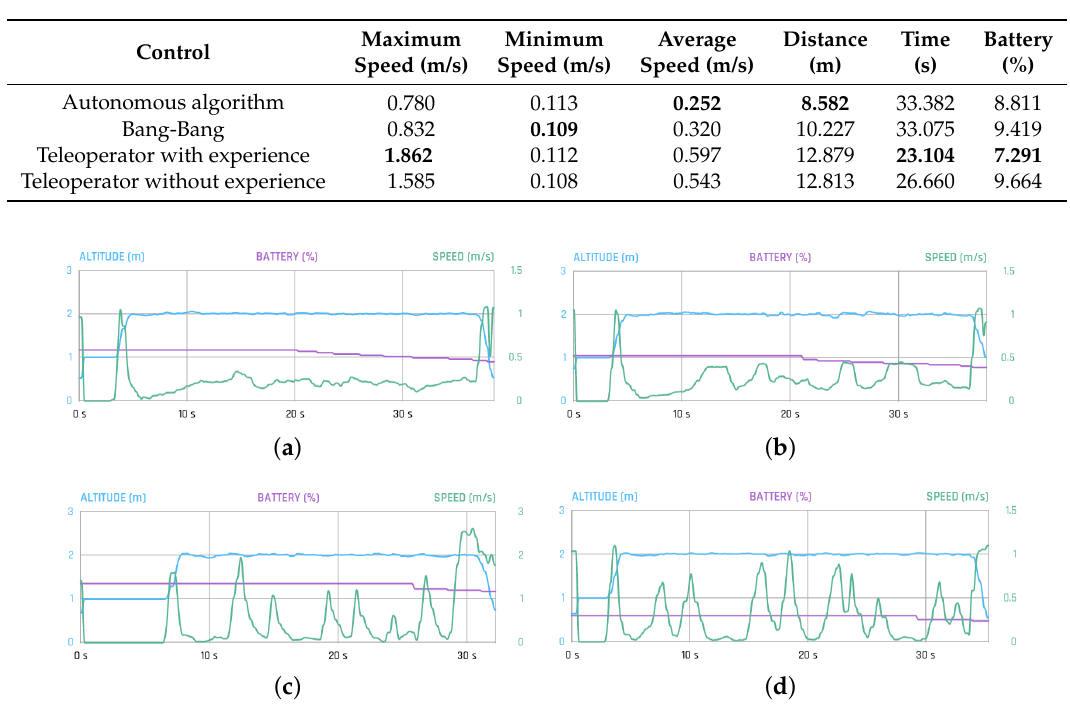
Table 2. Two fixed obstacles.